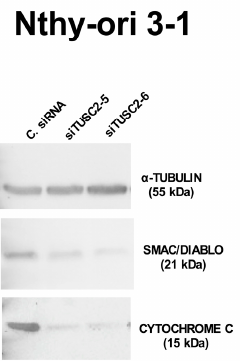
Figure 8. TUSC2 silencing decreased expression levels of SMAC/DIABLO and of CYTOCHROME C in the Nthy-ori 3-1 cell line. Nthy-ori 3-1 cells were transiently transfected with two different siRNAs (siTUSC2-5 or siTUSC2-6) or with Control siRNA (named C. siRNA). After 72 h, protein lysates were subjected to immunoblotting with the indicated antibodies.